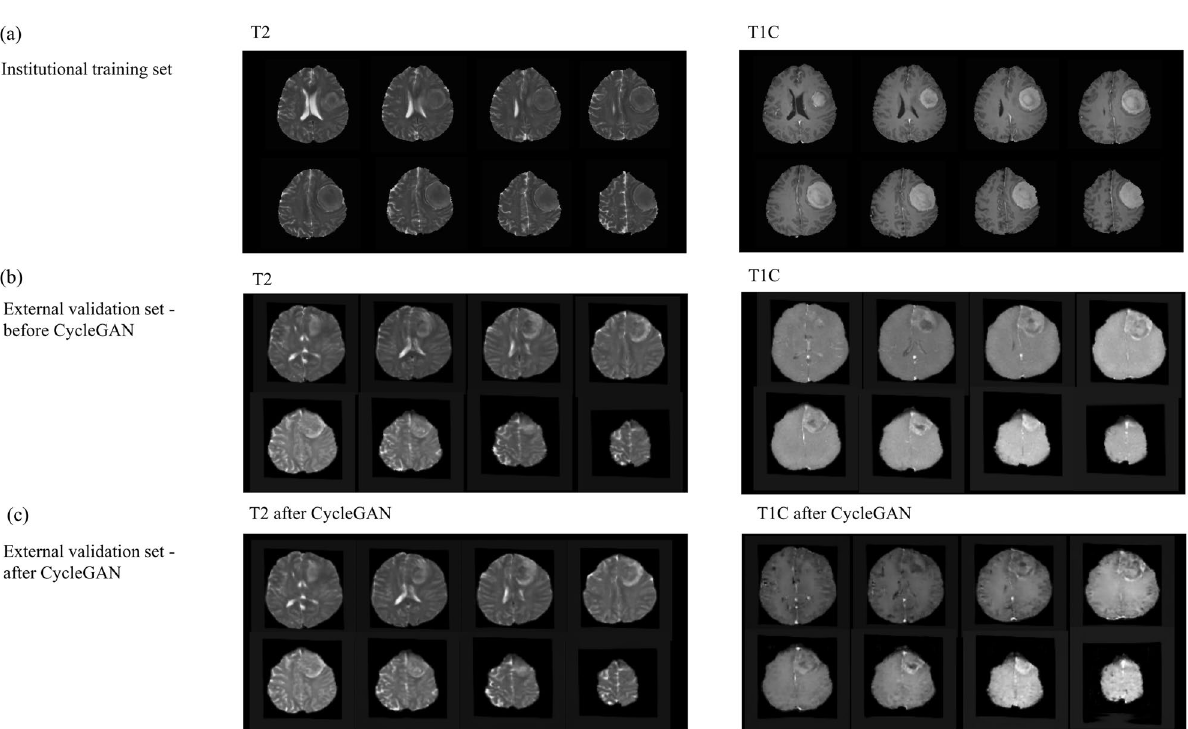
Figure 2. Representative cases showing the institutional training dataset and images before and after style transfer of the external validation set. ( a ) T2 and T1C images of a patient from the institutional training dataset that were leveraged to generate the radiomics model. ( b ) T2 and T1C images from the original external validation. ( c ) Style of T2 and T1C images from the external validation set after transformation to match that of the institutional training set images by using CycleGAN. CycleGAN = Cycle-Consistent Adversarial Networks, T1C = postcontrast T1-weighted image, T2 = T2-weighted